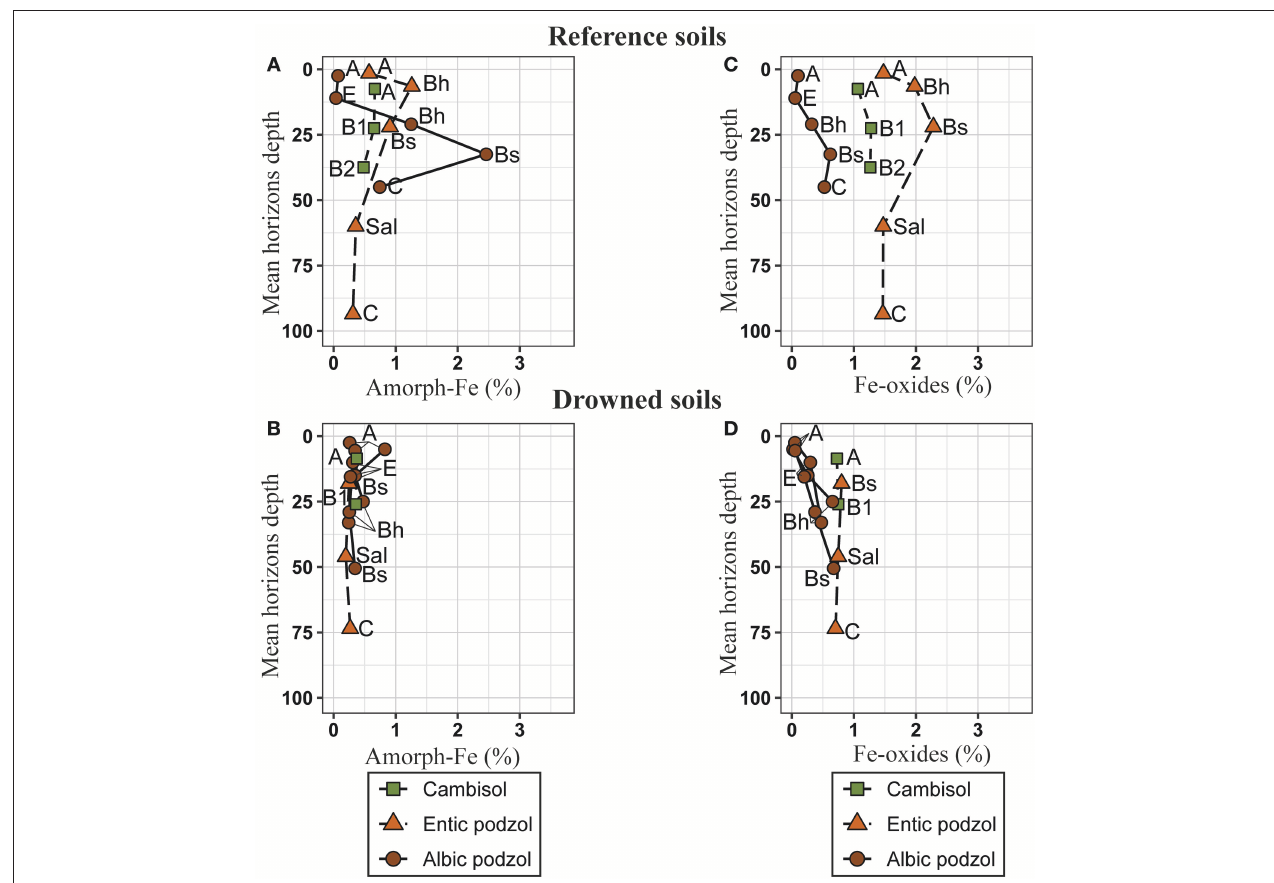
FIGURE 8 | Oxalate-extracted iron (Amorph-Fe) (%) of the horizons of reference soils (A) and drowned soils (B) . Iron oxides (Fe-oxides) (%) of the horizons of reference soils (C) and drowned soils (D) . Holorganic horizons are not shown. Green square: Cambisol. Orange triangle: Entic Podzol. Brown dot: Albic Podzol. Horizon names are specified beside each